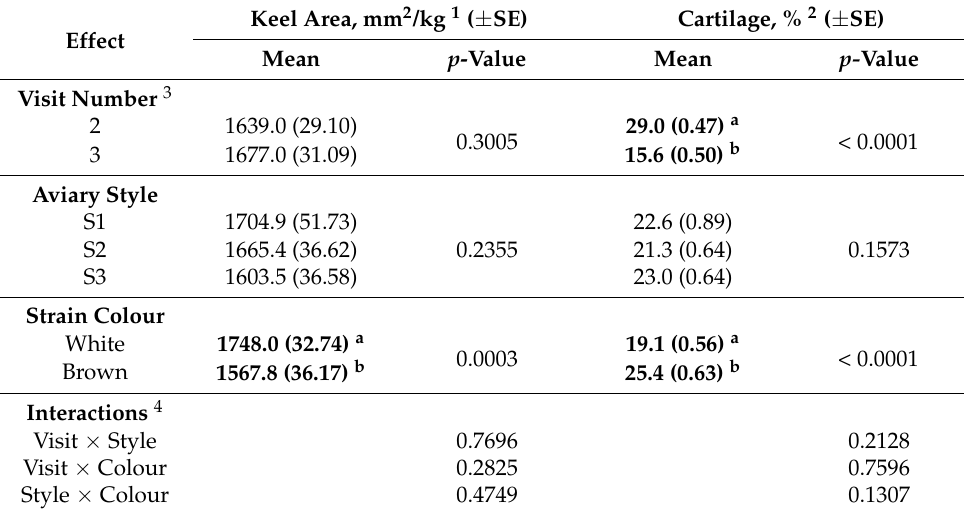
Table 8. Least square means ( ± standard error) of the proportional keel area (mm 2 /kg) and percentage of keel cartilage of brown- and white-feathered strains of layer pullets housed in three different styles of commercial rearing aviary systems of increasing structural complexity at approximately 10 and 16 weeks of